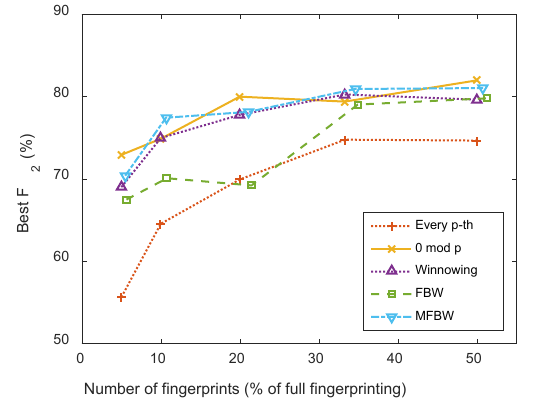
Fig. 1. Best F 2 value vs. the number of selected fingerprints. Full fingerprinting result is not shown – it is located at 100 % fingerprints and F 2 = 80.86 % as given in Table I.